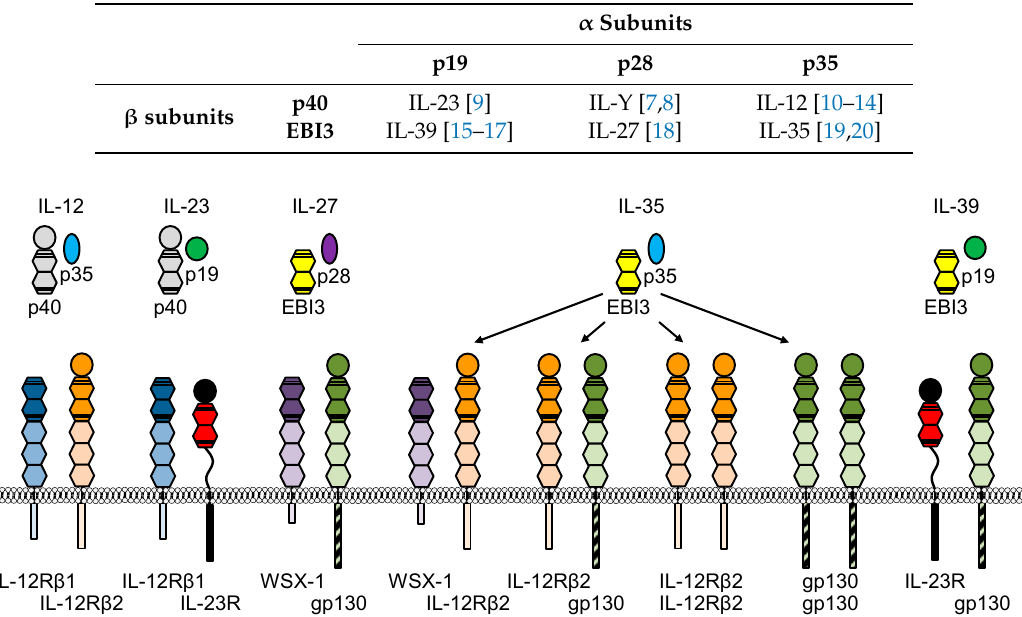
Figure 1. Cytokines and cognate receptors of the IL-12 family. Schematic overview of heterodimeric IL-12 type cytokines and their cognate receptors. IL-12, composed of IL-12p40 and IL-12p35, binds to the IL-12 receptor complex comprised of two receptors, IL-12R β 1 and IL-12R β 2. The heterodimeric cytokine IL-23 is formed by IL-12p40 and IL-23p19, and binds the IL-23 receptor complex comprised of IL-12R β 1 and IL-23R. EBI3 and IL-27p28 form IL-27, which binds to WSX-1 and gp130, the signal transducer of IL-6. IL-35 is composed of EBI3 and IL-12p35. Four different IL-35 receptor complexes have been proposed: WSX-1/IL-12R β 2, IL-12R β 2/gp130, IL-12R β 2/IL-12R β 2 and gp130/gp130. The cytokine IL-39, formed by EBI3 and IL-23p19, binds to gp130 and IL-23R. Ig-domains are shown as circles and in the same color as cytokine-binding homology region (CHR). Membrane proximal fibronectin-type-III domains are presented in light colors. The WSXWS motifs within IL-12p40, EBI3 and the receptors are indicated by thick black lines and conserved cysteine residues by thin black lines.